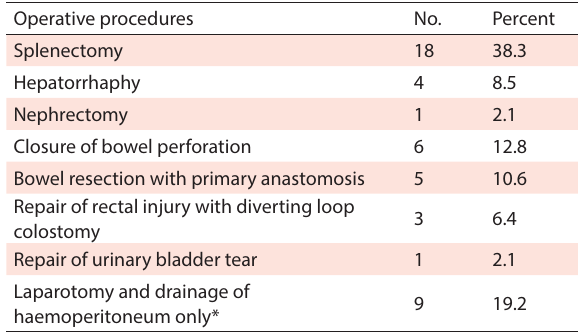
Table 5. Surgical procedures